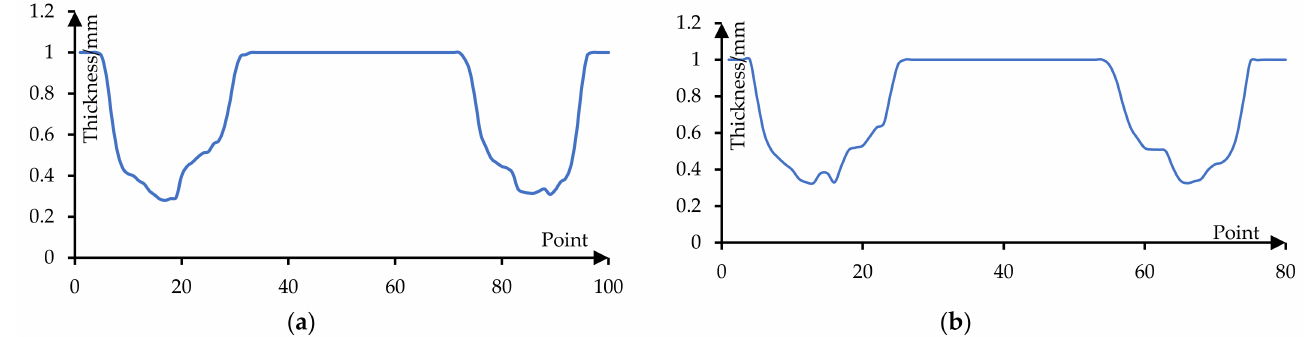
Figure 25. The thickness distribution curve (5 ◦ ): ( a ) the thickness of the long axis section and ( b ) the thickness of the short axis section.